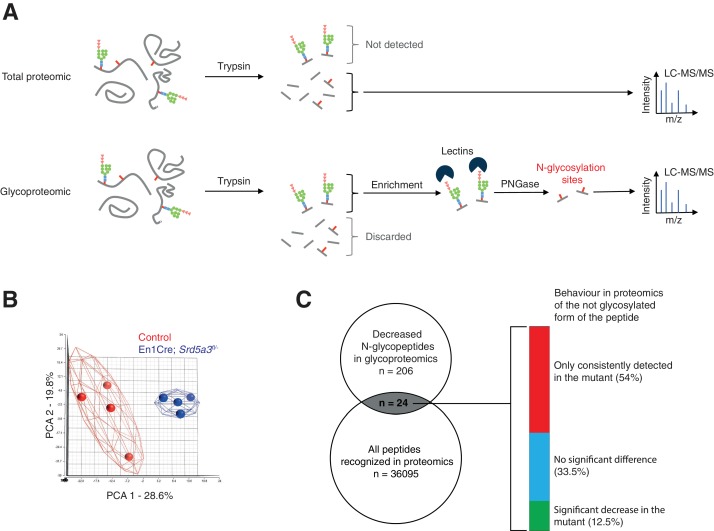
Extended glycoproteomic analysis results and validation.(A) Outline of the total proteomic and glycoproteomic techniques. In regular total proteomics, the proteins are digested into peptides by trypsin. Peptides containing an N-glycan chain cannot be recognized by LC-MS/MS due to consequent changes in ion charge and mass. Only the not glycosylated form of the peptide is recognized, if it exists. In glycoproteomics, only the N-glycosylated peptides will be retained (lectin enrichment). After PNGase treatment, the peptide is released are then analyzed by LC-MS/MS. (B) PCA based on the MS intensities of the 1404 N-glycopeptides consistently detected in control samples. (C) Qualitative behavior of N-glycopeptides with lower abundance in mutant samples (glycoproteomics analysis) and also detected in the total proteomics analysis. Total proteomics analysis detected most of the peptides (54%) in mutant samples only, a result consistent with constant glycosylation site occupancy in controls and hypoglycosylation in mutants.